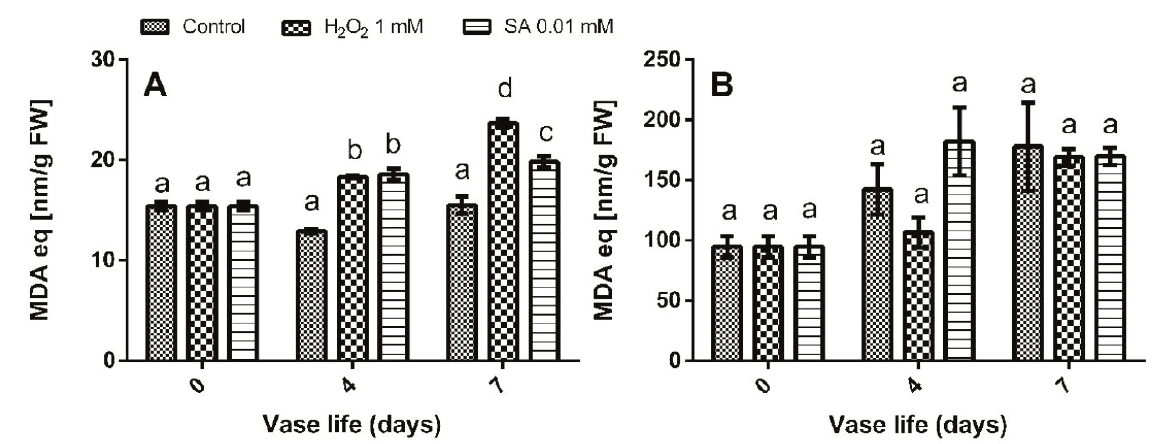
(p<0.05).Fig. 4 - Changes in lipid peroxidation in leaves (A) or petals (B) of cut ‘Tacazzi’ rose during vase life and in response to treatments. Data are means ± SE (n=3). Different letters indicate significant differences